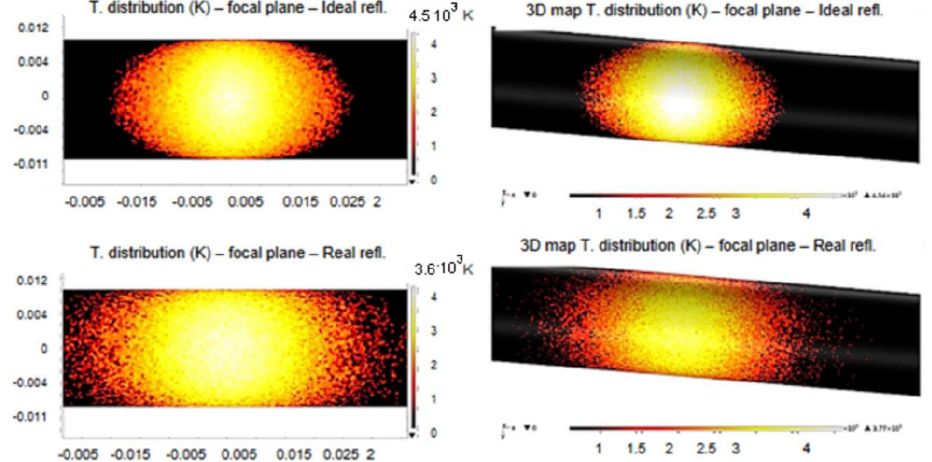
Figure 14. Two-/three-dimensional temperature distribution in the focal plane of the receiver. Ideal case ( above ): perfectly smooth and reflective parabolic reflector; the phenomenon of solar limb darkening was neglected. Real case ( below ): parabolic reflector in which factors such as surface roughness, absorption and solar limb darkening were included. Table 2. Maximum thermal flow values deposited in focal plane of receiver and relative maximum power in target assessed assuming area of concentration with radius equal to 1 cm.